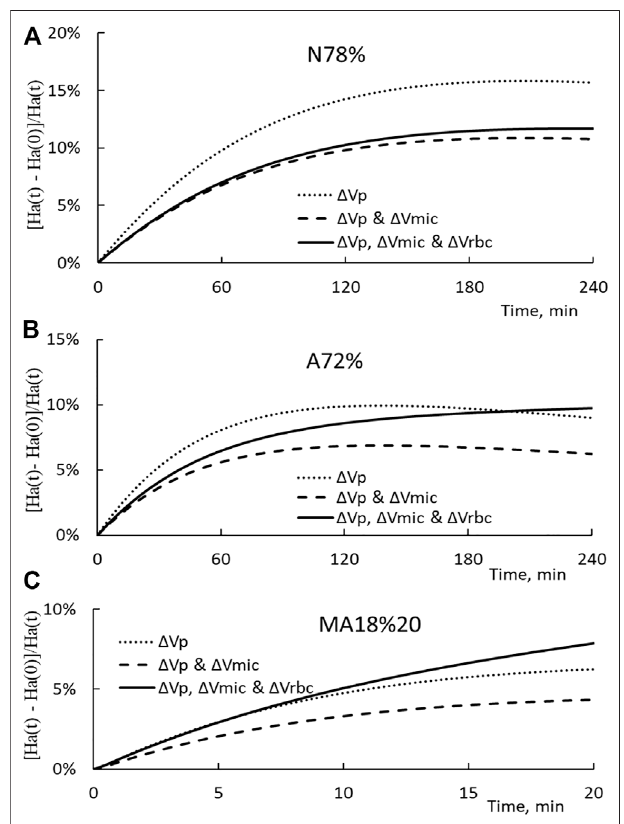
FIGURE 7 | (A) Temporal changes in the arterial hematocrit increment Ha(t)-Ha (0)/Ha(t) for the N78% HD. The dotted, broken, and solid lines show the increment induced only by Δ Vp, Δ Vp, and Δ Vmic, and all three Δ Vp, Δ Vmic, and Δ Vrbc, respectively. (B) Temporal changes in the arterial hematocrit increment for A72% HD. (C) Temporal changes in the arterial hematocrit increment for MA18%20